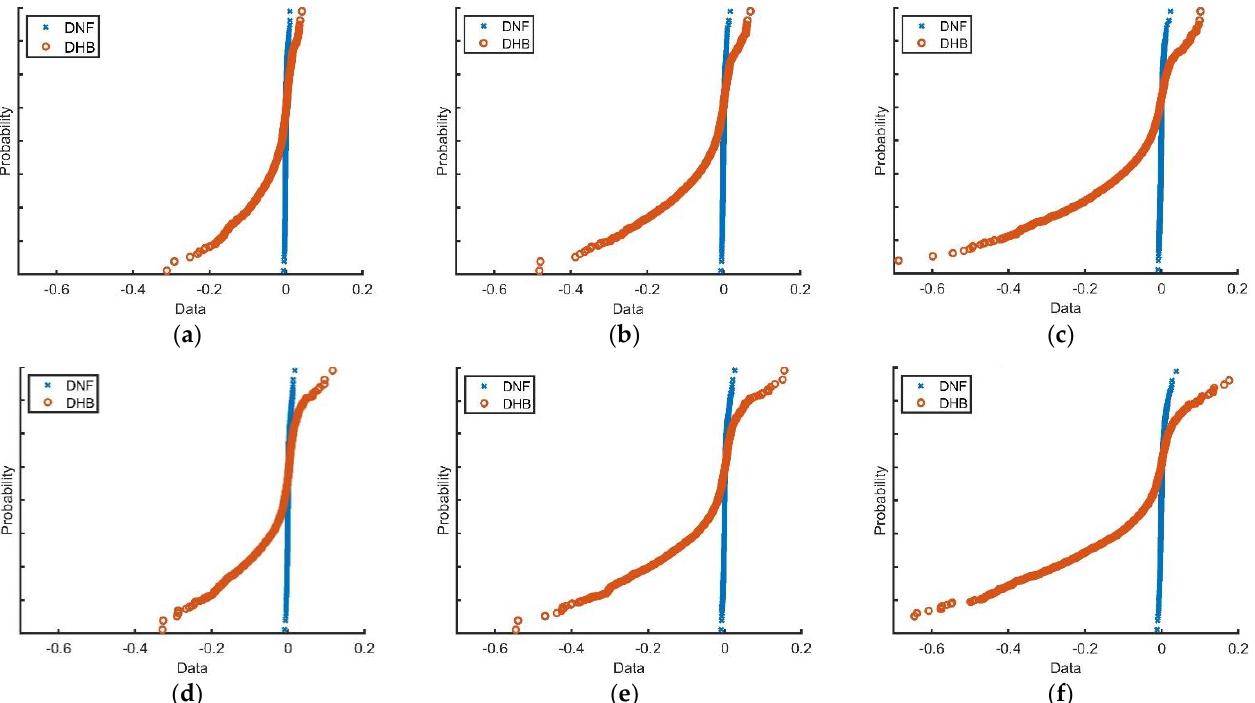
Figure 3. Cover image, SRM, high-boost, high-boost with SRM filtered image. ( a ) Cover image. ( b ) SRM filtered image. ( c ) High-boost filtered image. ( d ) SRM filtered image of Figure 3c.